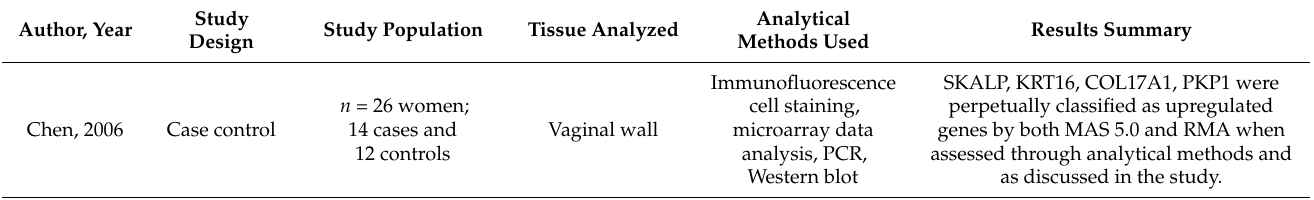
Table 2. General characteristics of